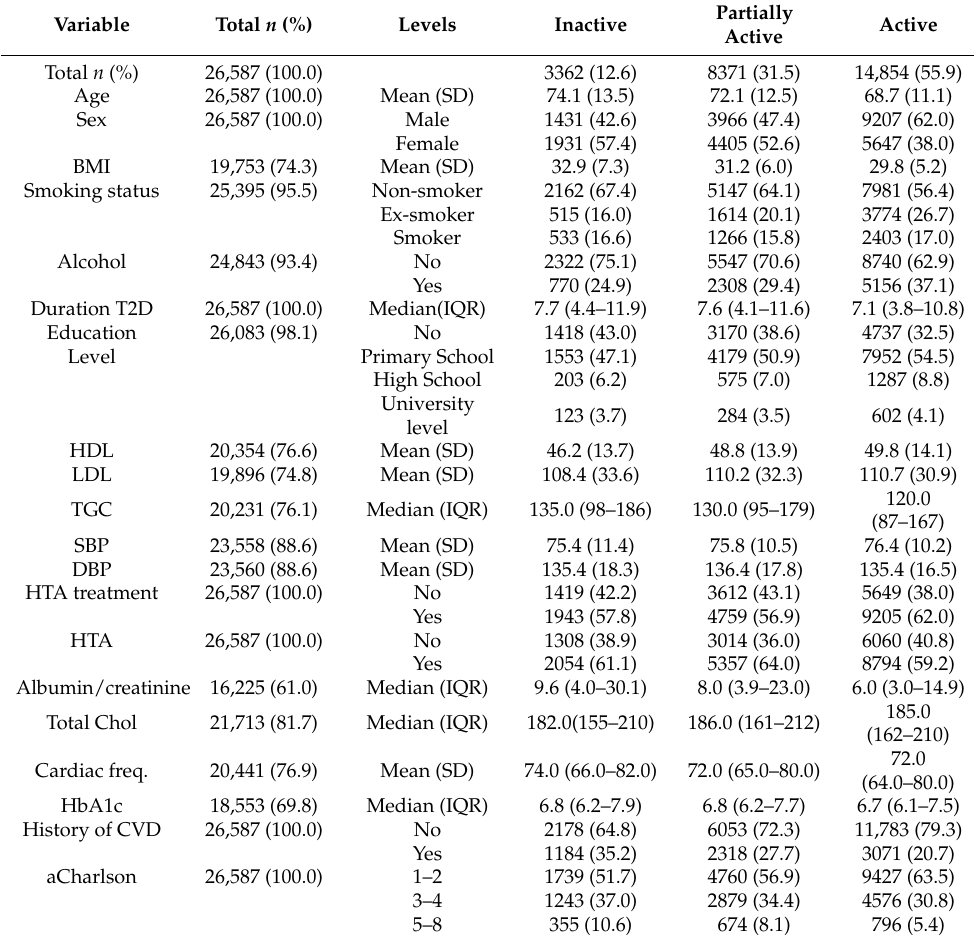
Table 1. Baseline characteristics according to physical activity among subjects with Type 2 Diabetes.